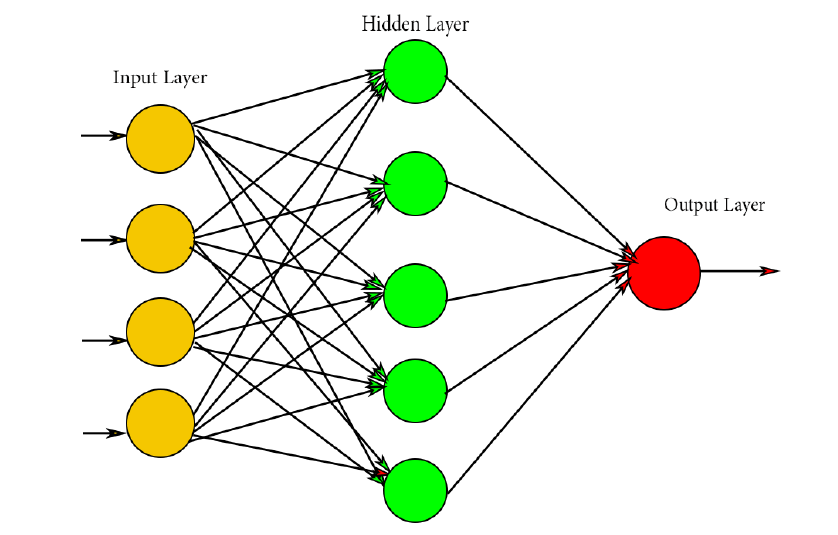
Figure 5. The architecture of an exemplary artificial neural